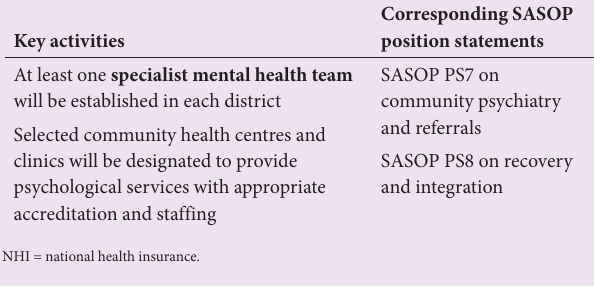
Table 1. National Objective 1: District based mental health services and primary healthcare re-engineering (initial focus on NHI pilot sites)